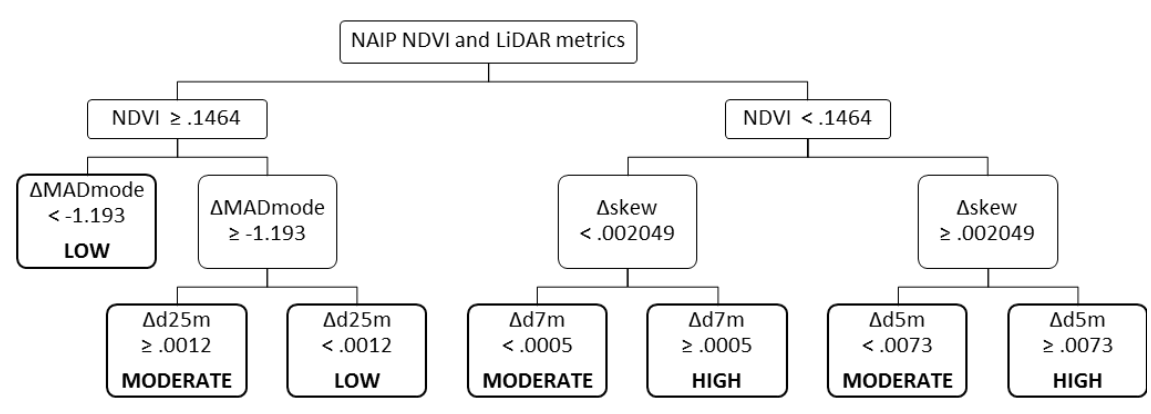
Figure 7. Classification tree for Model C, imagery and differenced LiDAR.